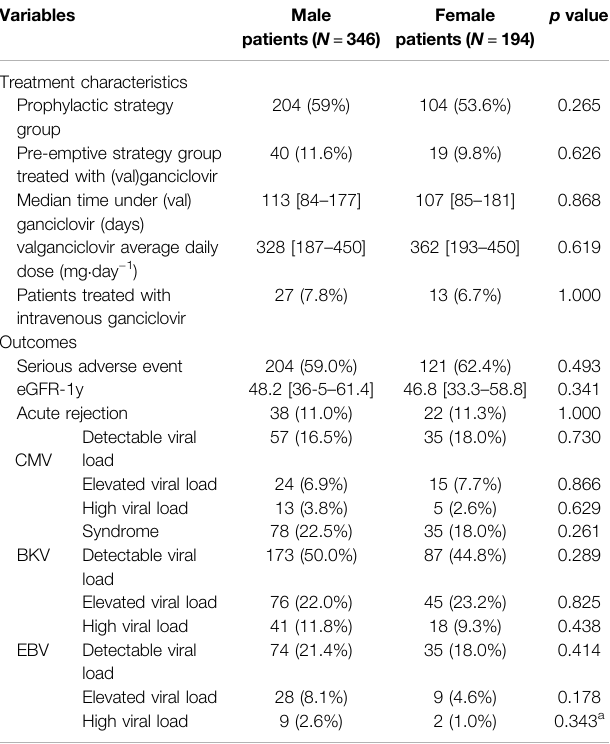
TABLE 3 | Differences between sexes in treatment characteristics and outcomes of the fi rst post-transplantation year.